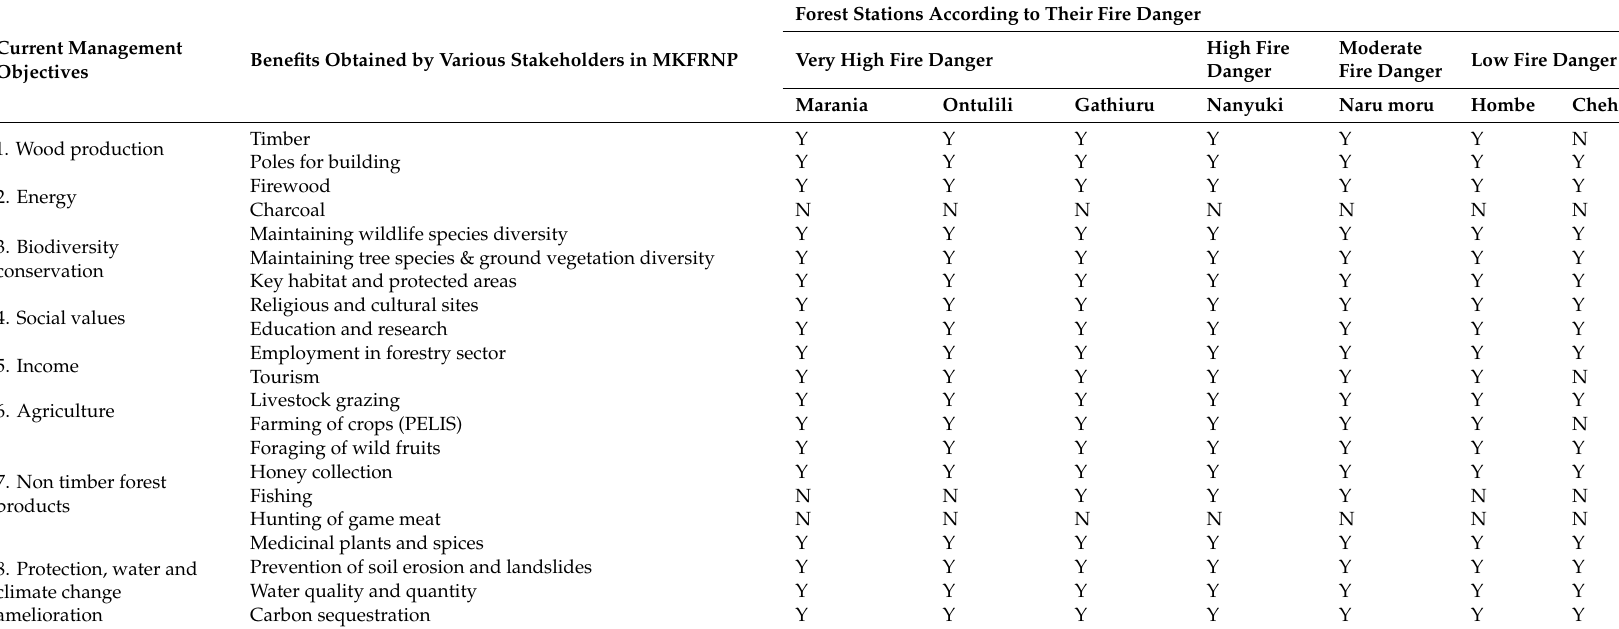
Table A2. The current management objectives that are being implemented by the KFS and KWS and benefits obtained by various stakeholders in the seven forest stations in